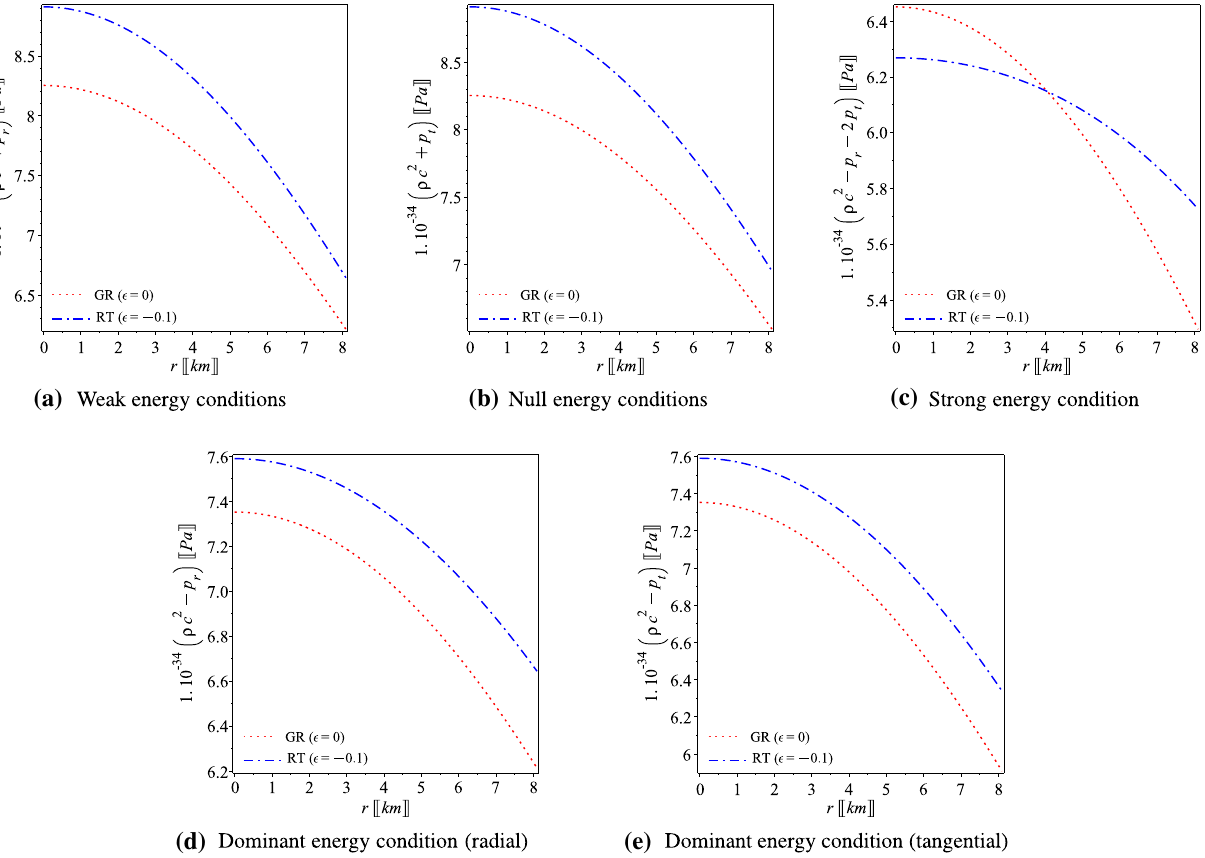
Fig. 4 The weak, null, strong and dominant energy conditions, using Eqs. (21), versus the radial coordinate r in km for the pulsar Her X-1 . The plots show that the model fulfill the energy conditions (vii) in Sect.